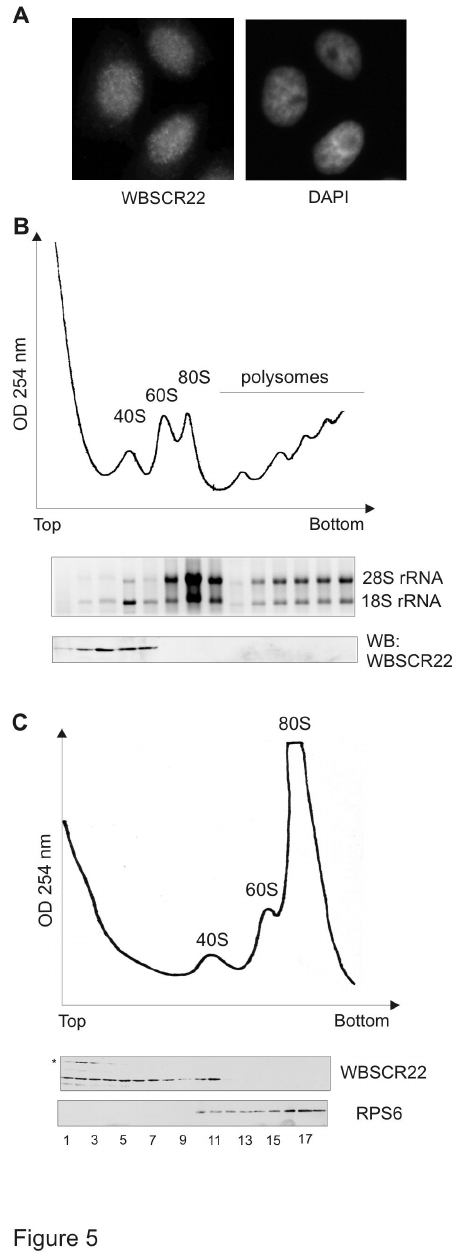
Figure 5. Localization of the WBSCR22 protein within the cell. (A) Subcellular localization of WBSCR22 by immunofluorescence analysis. The localization of endogenous protein in HeLa cells was analyzed by anti-WBSCR22 antibody. DAPI was used to stain the nucleus of the cell. (B) Total extracts of HeLa cells were centrifuged on 10-50% sucrose gradient at 27 000 rpm for 4 hours and fractionated. The 18S and 28S rRNAs were detected by ethidium bromide and the WBSCR22 protein was analyzed by western blotting using anti-WBSCR22 antibodies. (C) HeLa cell extracts were centrifuged on 10-50% sucrose gradient at 27 000 rpm for 13 hours and analyzed by western blotting. doi: